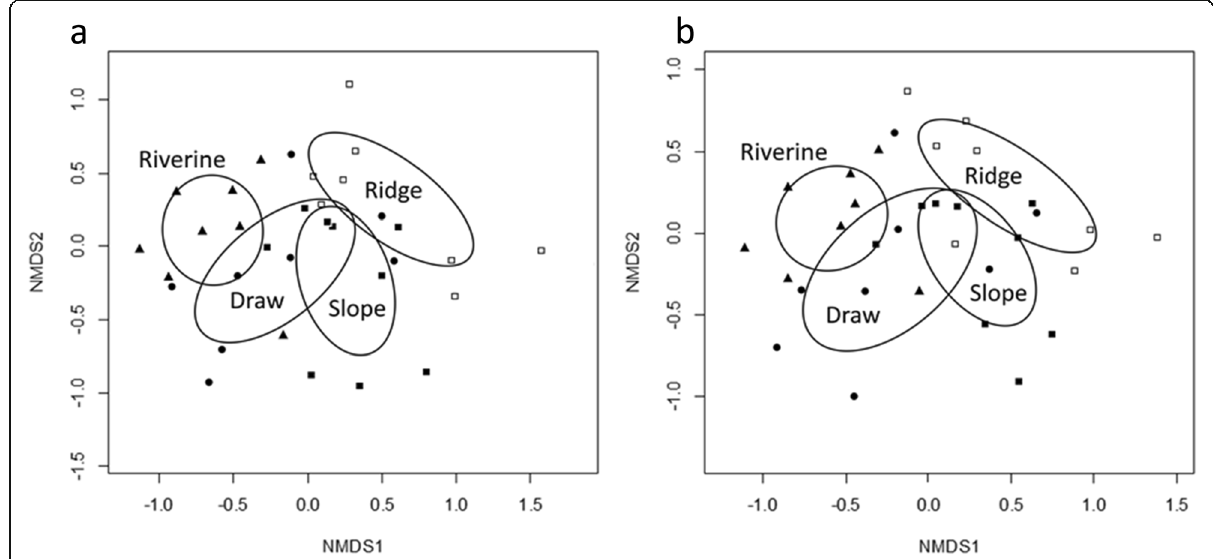
Fig. 2 NMDS ordinations of the forest tree biodiversity in 1997 ( a ) and 2005 ( b ) with factor fit of landform type. Riverine sites = triangles, draw sites = circles, slope sites = closed squares, ridge sites = open